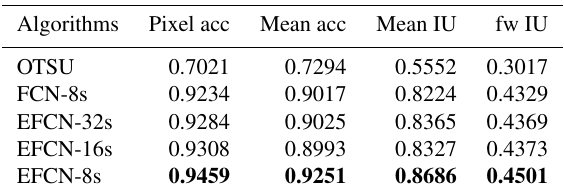
Table 3. Comparison of cloud segmentation results of different al- gorithms on nocturnal ASI images. The enhanced performance val- ues are highlighted in bold font.